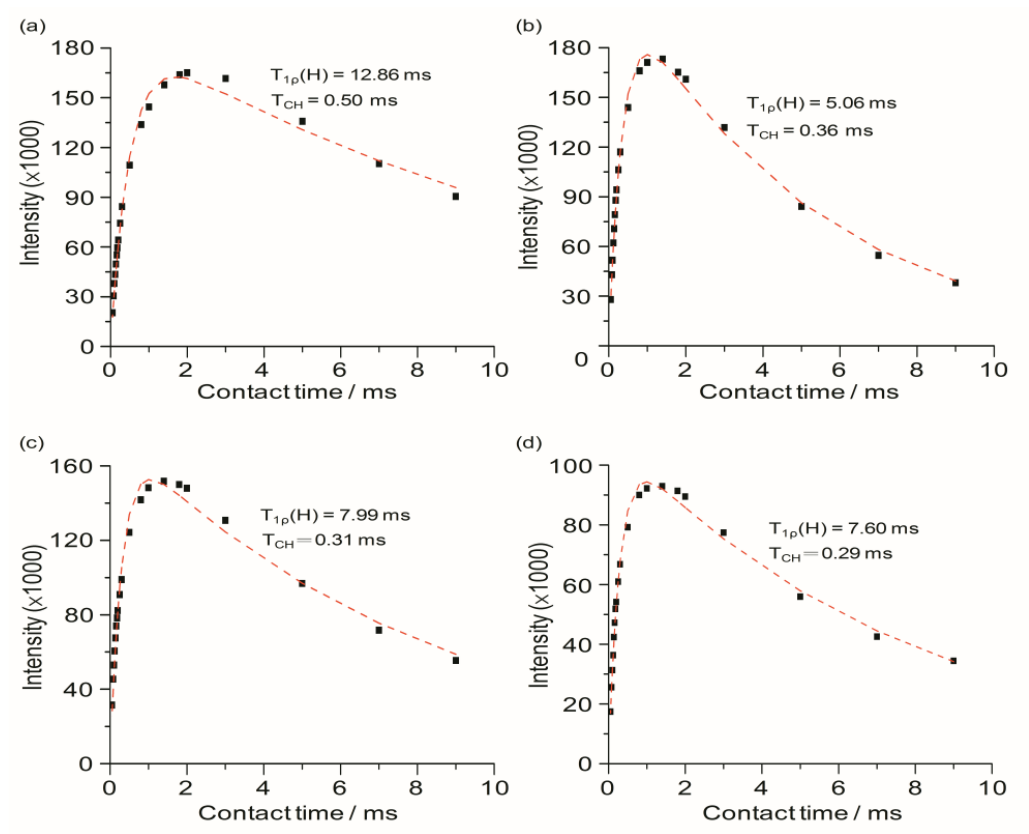
Figure 6. 13 C CPMAS NMR spectra (70.7 ppm) of TIE(600)-Z hybrid electrolytes with Z = ( a ) 32; ( b ) 24; ( c ) 16 and ( d ) 8, as a function of contact